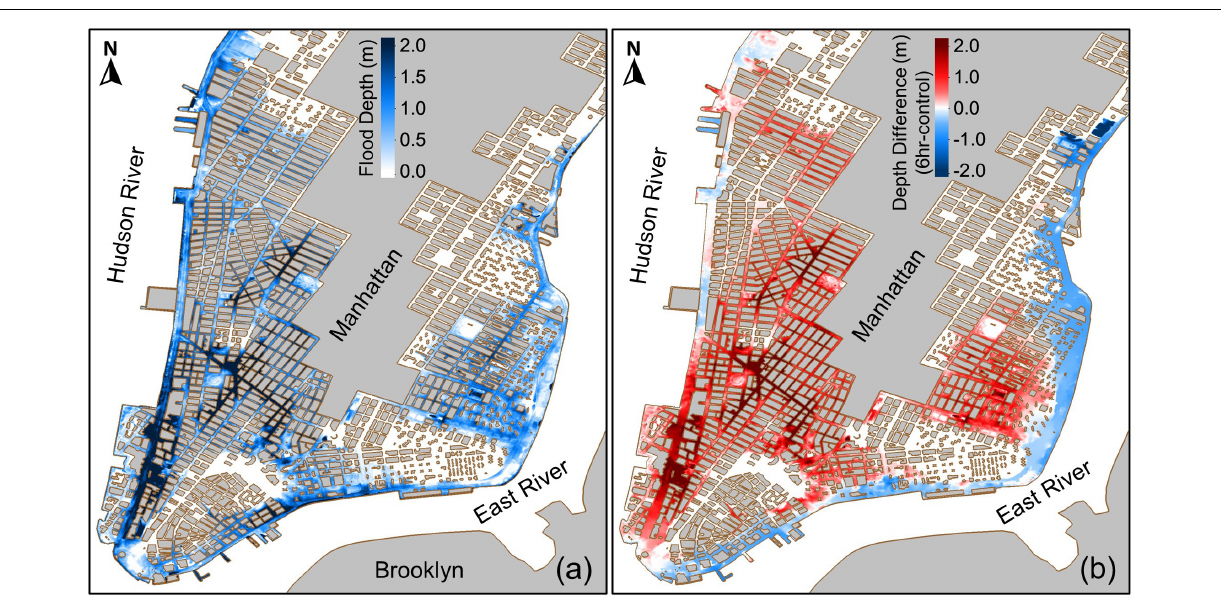
FIGURE 10 | (a) Spatial distribution of maximum flood depth in the study area based on the 6 h early experiment and (b) the difference in the maximum flood depth based on the control run and the 6 h early